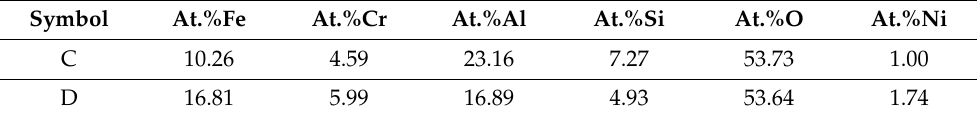
Table 3. EDS analysis results at the mark of the sample coated with nine-layer of mullite film.